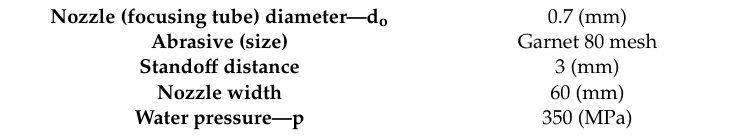
Table 2. Constant technological parameters of abrasive waterjet (AWJ) cutting.